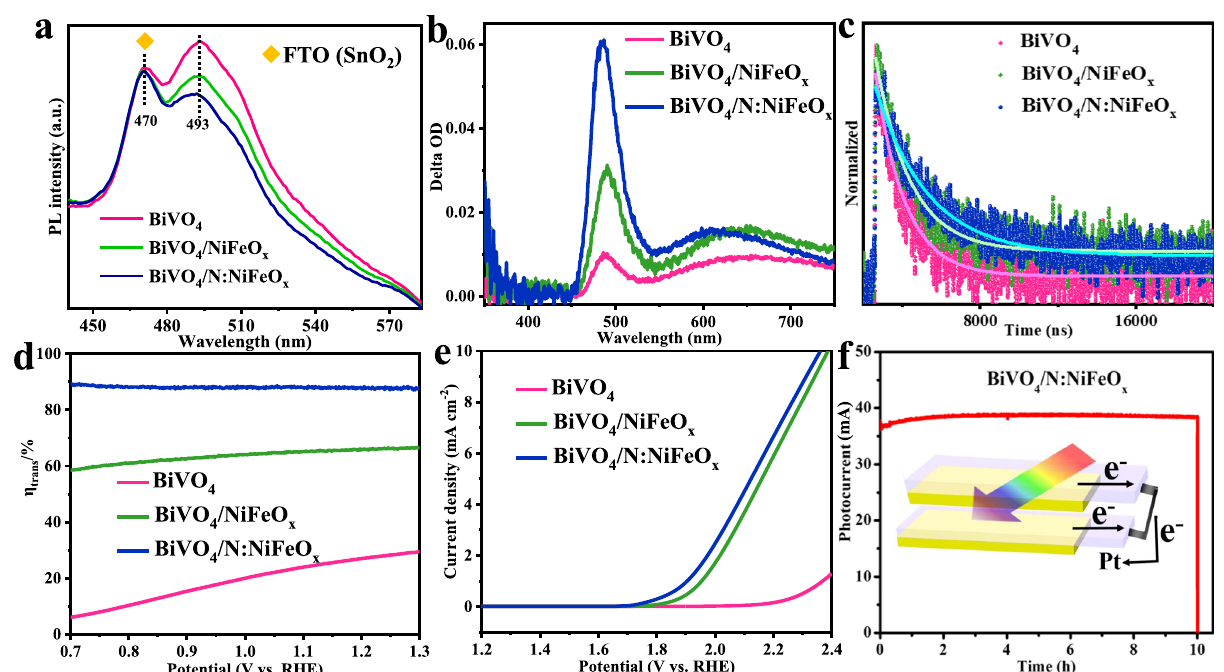
Fig. 3 Spectrum and electrochemical OER properties. a PL spectra; b transient absorption (TA) spectra; c the time-resolved TA curves probed at 490 nm; d charge transfer ef fi ciencies ( η trans ); and e LSV curves in the dark of BiVO 4 , BiVO 4 /NiFeO x , and BiVO 4 /N:NiFeO x photoanodes. f I – t curves of the scale-up fabricated BiVO 4 /N:NiFeO x photoanodes (2 × 3.5 cm 2 ) with parallel at 1.23 V RHE